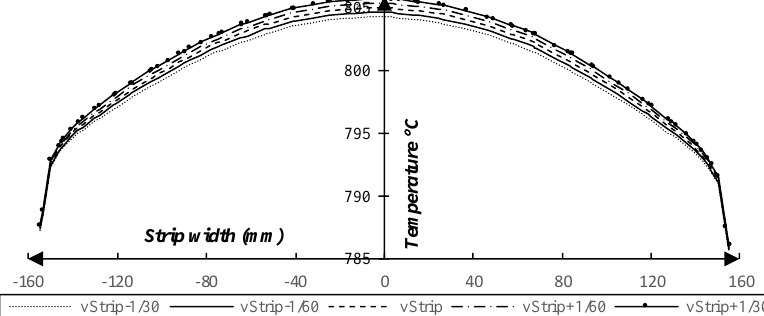
Figure 13. The effect of different strip velocities on the strip temperature. Gas inlet and outlet position: Figure 10b. Table 4. Temperature values resulting from the different strip velocities at the specific position. The Velocity of the Strip (m/s)